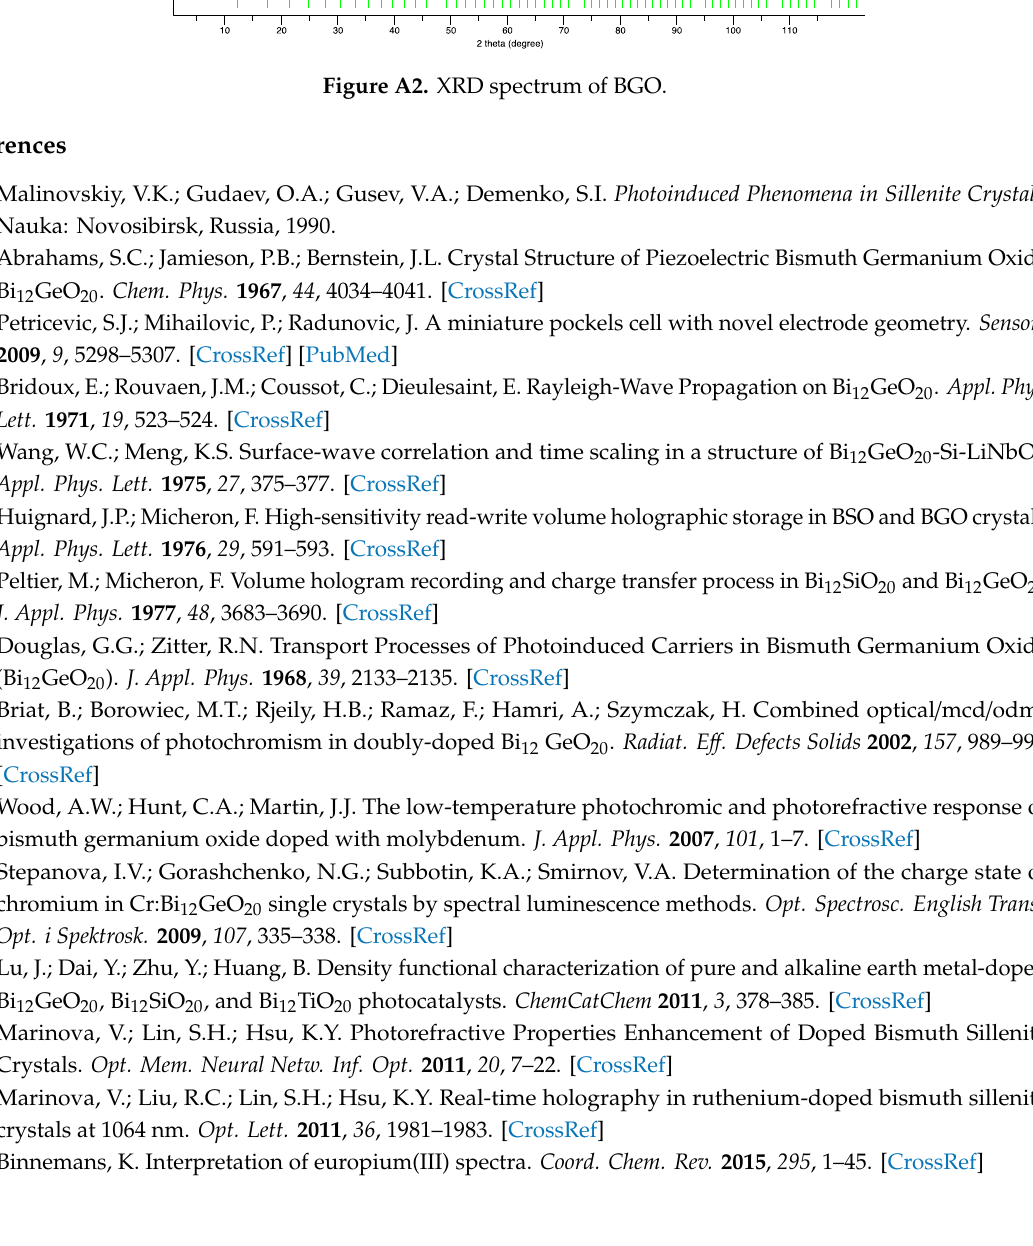
Figure A2. XRD spectrum of BGO.